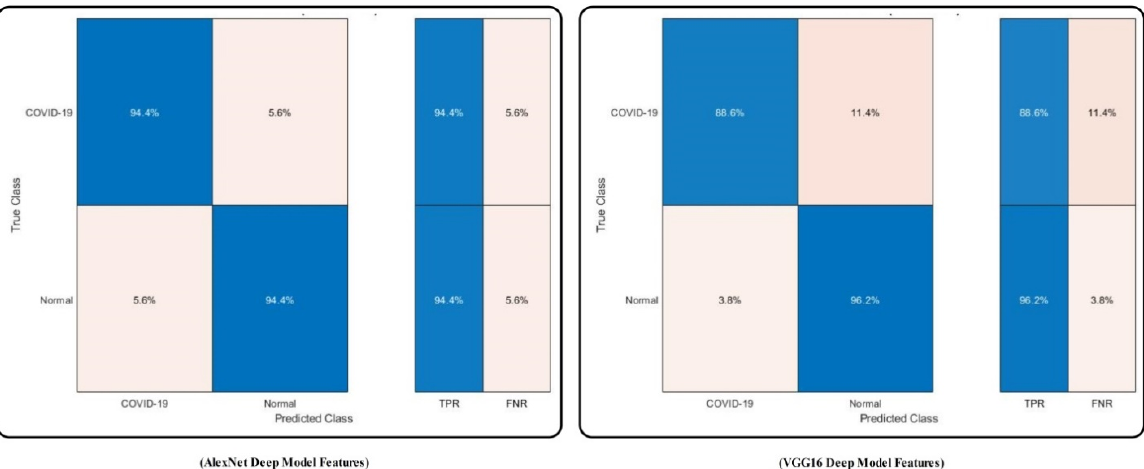
Figure 8. Confusion matrix of MC-SVM to verify the achieved accuracy using original deep model features after transfer